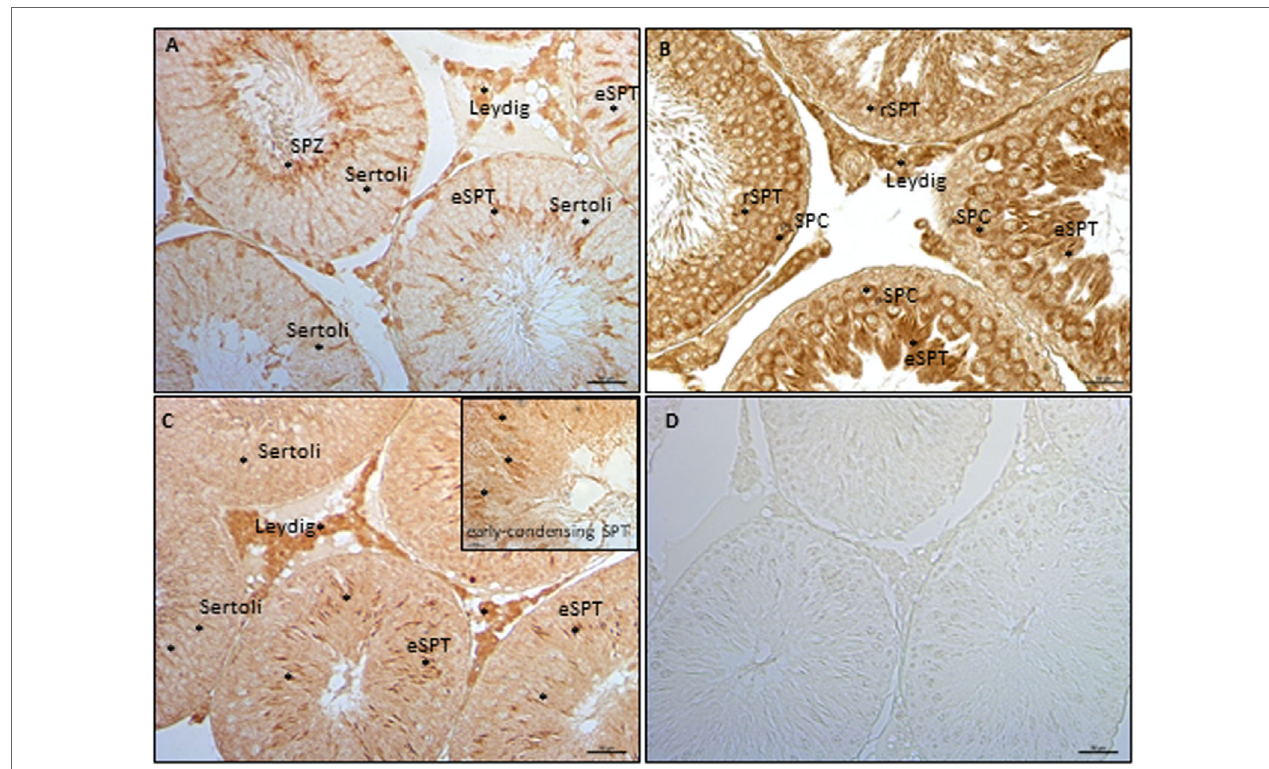
FigUre 5 | Immunocytochemistry analyses of endocannabinoid system components in testis from rat at 90 days post partum . Immunolocalization of NAPE-PLD (a) , fatty acid amide hydrolase (B) , and monoacylglycerol-lipase (c) proteins in interstitial and tubular compartments. Asterisks indicate immunopositive cells. Specificity of reaction was checked by omitting the primary antibody (D) . Scale bar: 50 µm; inset scale bar: 10